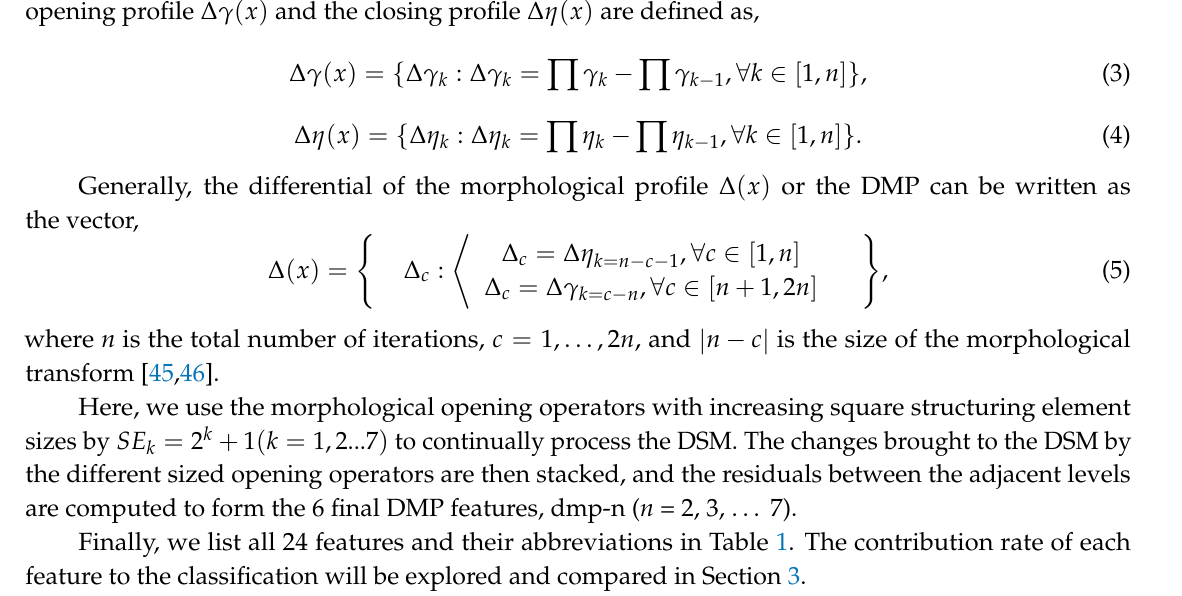
Table 1. Different types of features and their abbreviations used in this work.